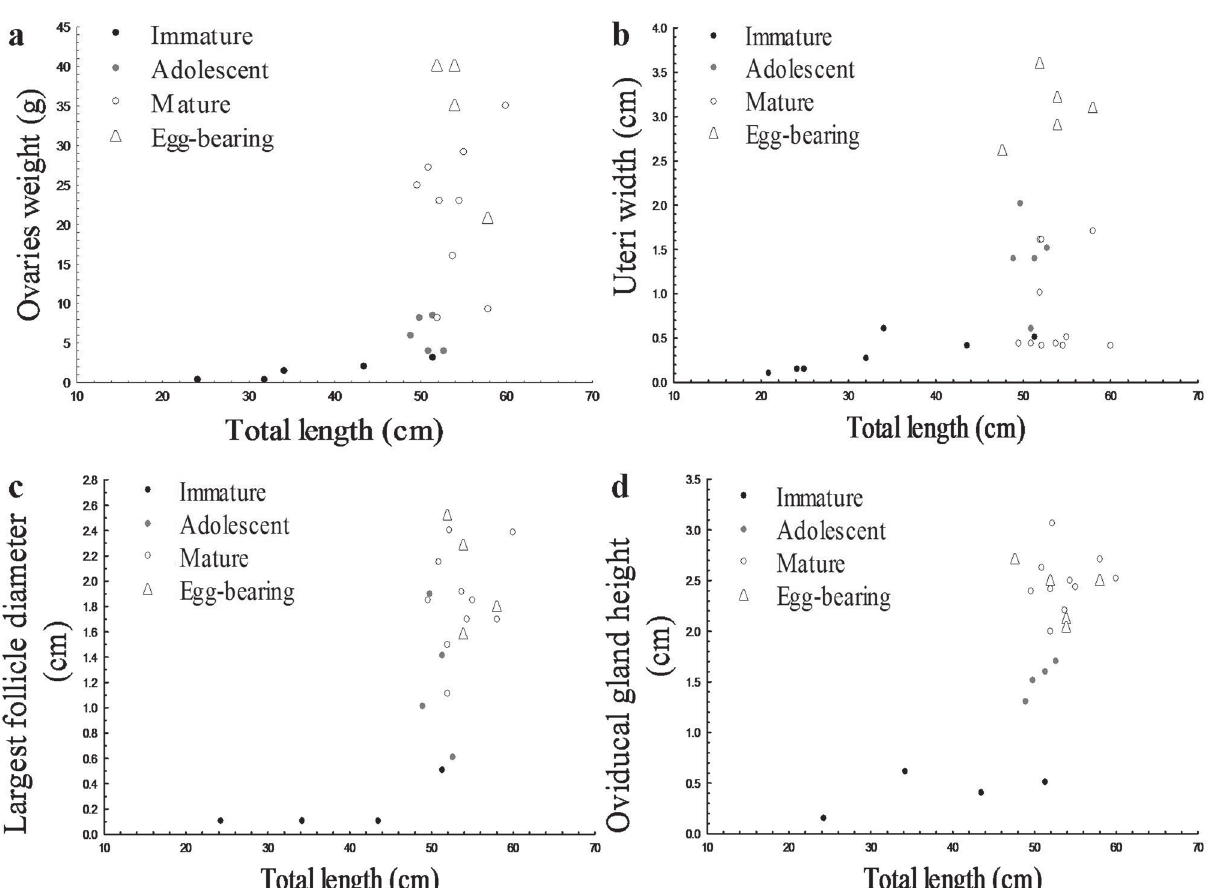
Fig. 7. Sexual development for females of Sympterygia acuta . Relationship between total length (cm) and (a) ovaries weight, (b) uteri width (cm), (c) diameter of the largest follicle (cm) and (d) oviducal gland height